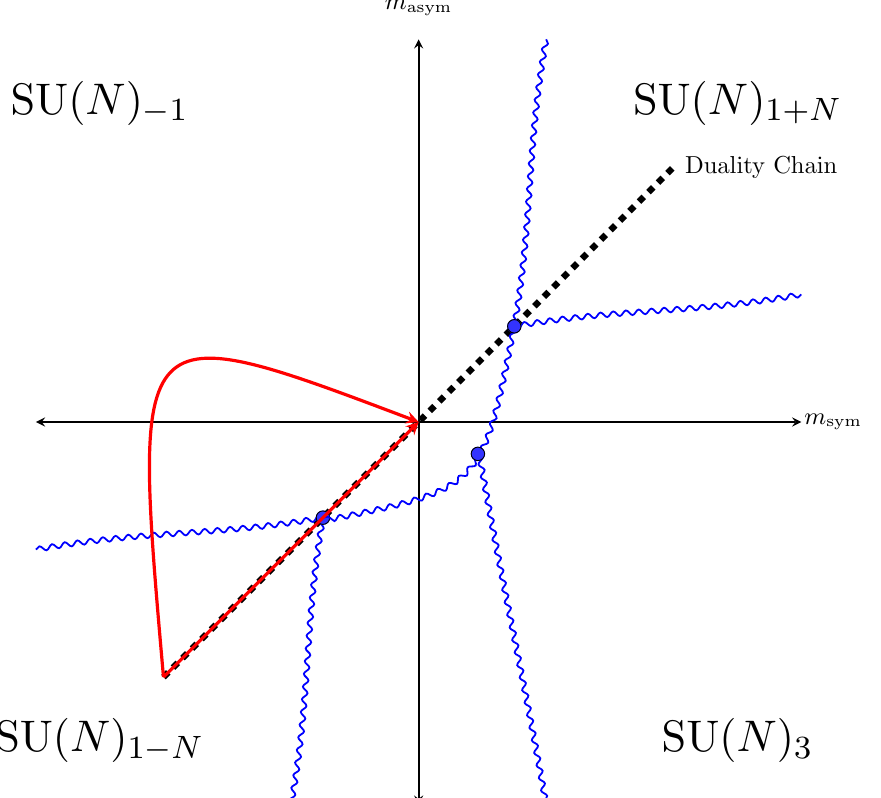
Figure 15 . Generic shape of the two dimensional phase diagram for SU( N ) 1 + sym + asym . The diagonal black line represent the region where duality chain applies. Straight and curved red lines represent the two di(cid:11)erent paths connecting SU( N ) 1 (cid:0) N and the middle quantum phase by duality chain and 2d phase diagram analysis respectively. Blue wavy lines describe various phase transitions expected from a e(cid:11)ective single adjoint theory at the asymptotic regions of the plane. The detailed shape of the critical lines at the bottom and right part is not important for the main